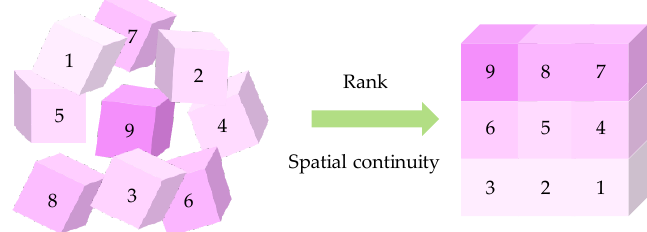
Figure 3. Schematic of convolutional kernel spatial information ranking.